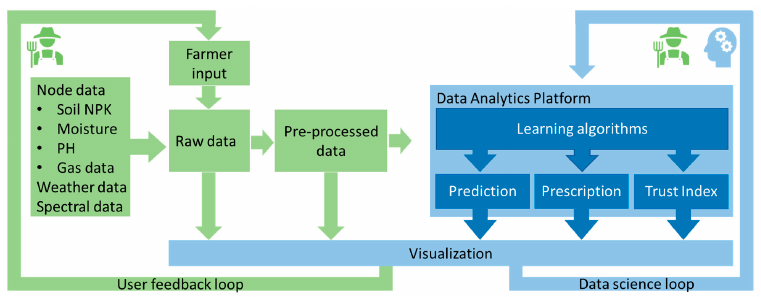
Figure 21. Analytics Platform: Data Flow, Main Processes and Feedback